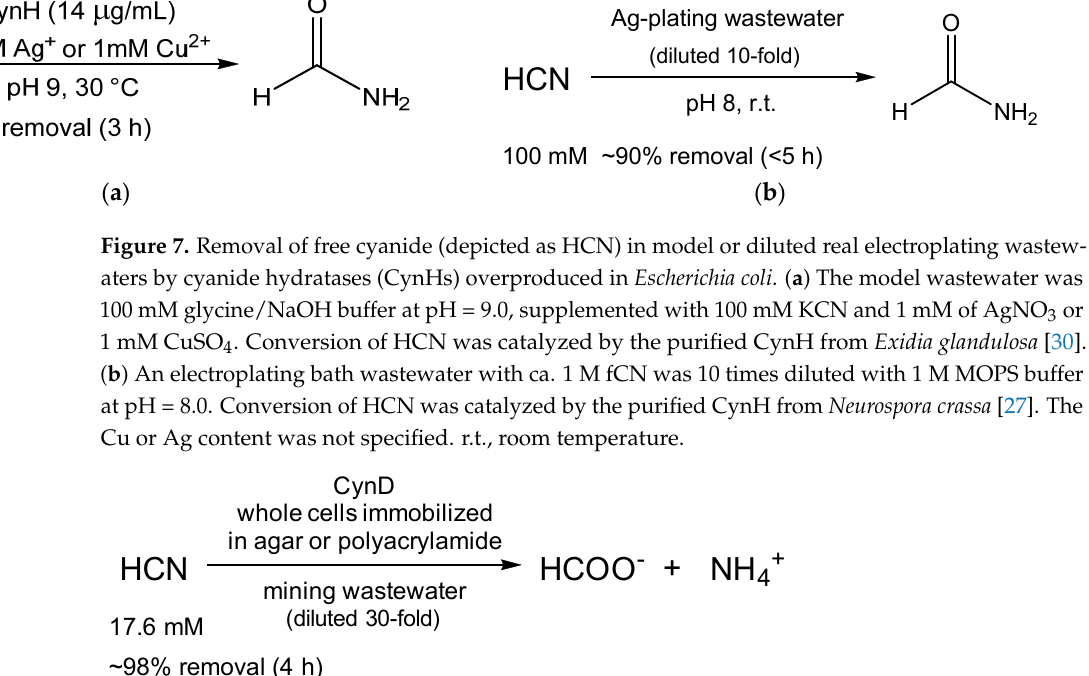
Figure 8. Biodegradation of free cyanide (depicted as HCN) in diluted gold-mining wastewater (“barren solution”, i.e., the solution from which no more gold can be obtained) by immobilized whole-cell catalyst based on the cyanide dihydratase (CynD) from Bacillus pumilus . The enzyme was overproduced in Escherichia coli and used as whole cells immobilized in agar or polyacrylamide beads [62].